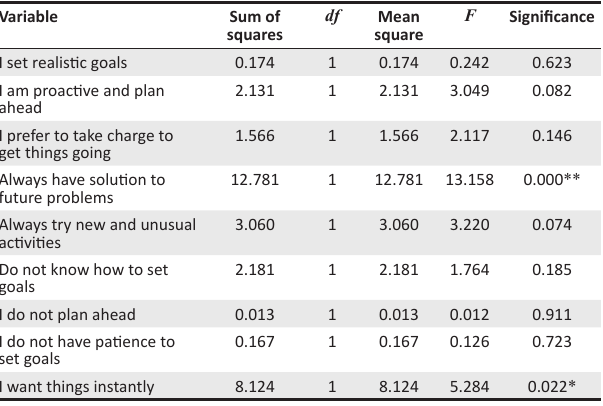
TABLE 4: Analysis of variance test on proactiveness versus starting a business in the absence of social grant income. df Mean Variable Sum of squares